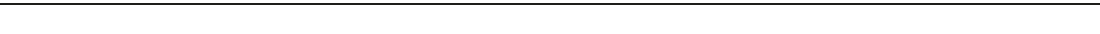
Fig. 5 VEGFR regulates angiogenesis and tumor VM through YAP/TAZ in vitro. a Transient knockdown of YAP and/or TAZ in MCF10A overexpressing VEGFR2 decreases expression of ANG-2 and CYR61. Western blotting exposures indicate relative expression of YAP and TAZ. b , c VEGFR2